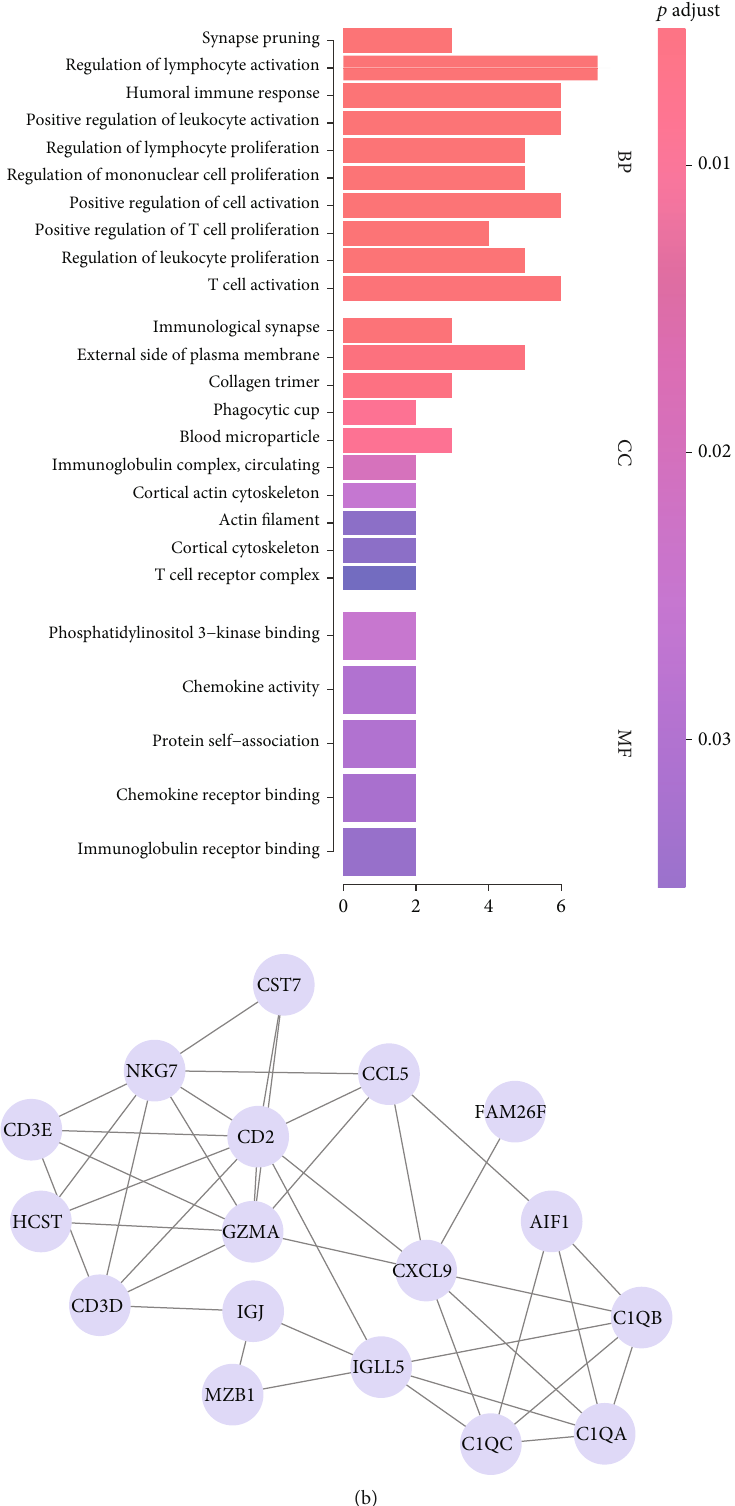
Figure 3: Functional analysis and protein-protein network of grey60 and magenta modules. (a) Grey60 module. (b) Magenta